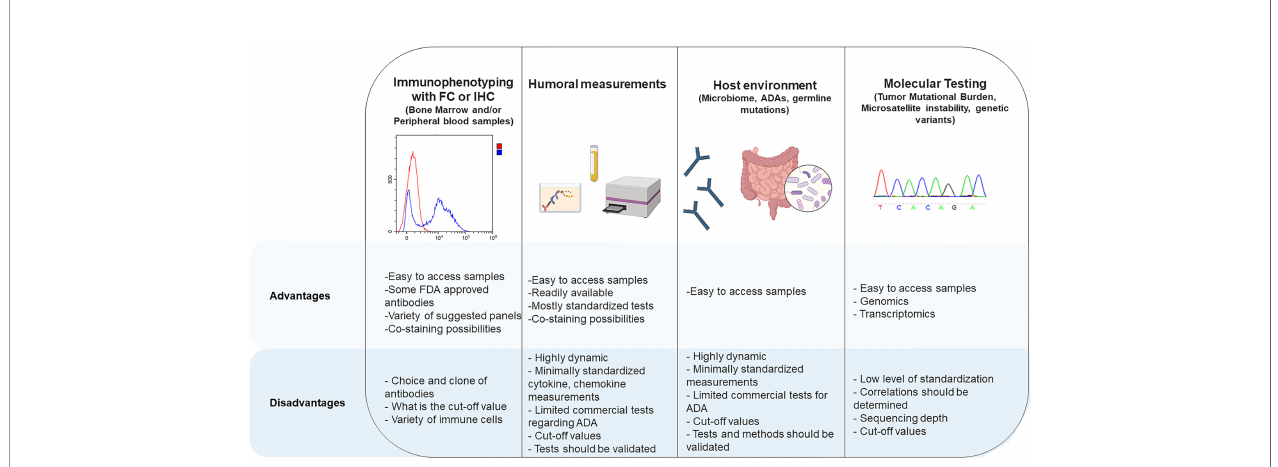
FIGURE 2 | Advantages and disadvantages of different methods for measurement of checkpoint inhibitors and their interactions with other